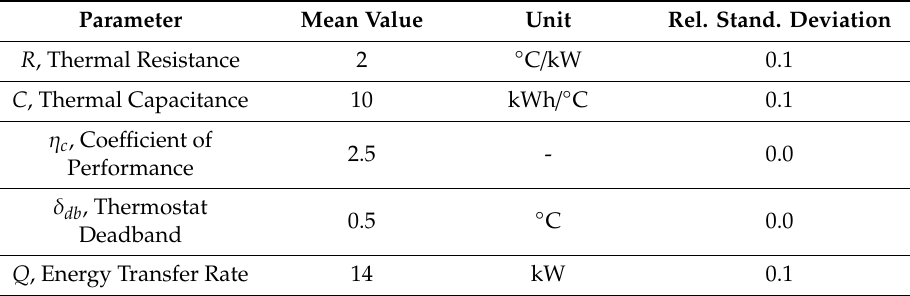
Table 2. System parameters adopted from Reference [14].